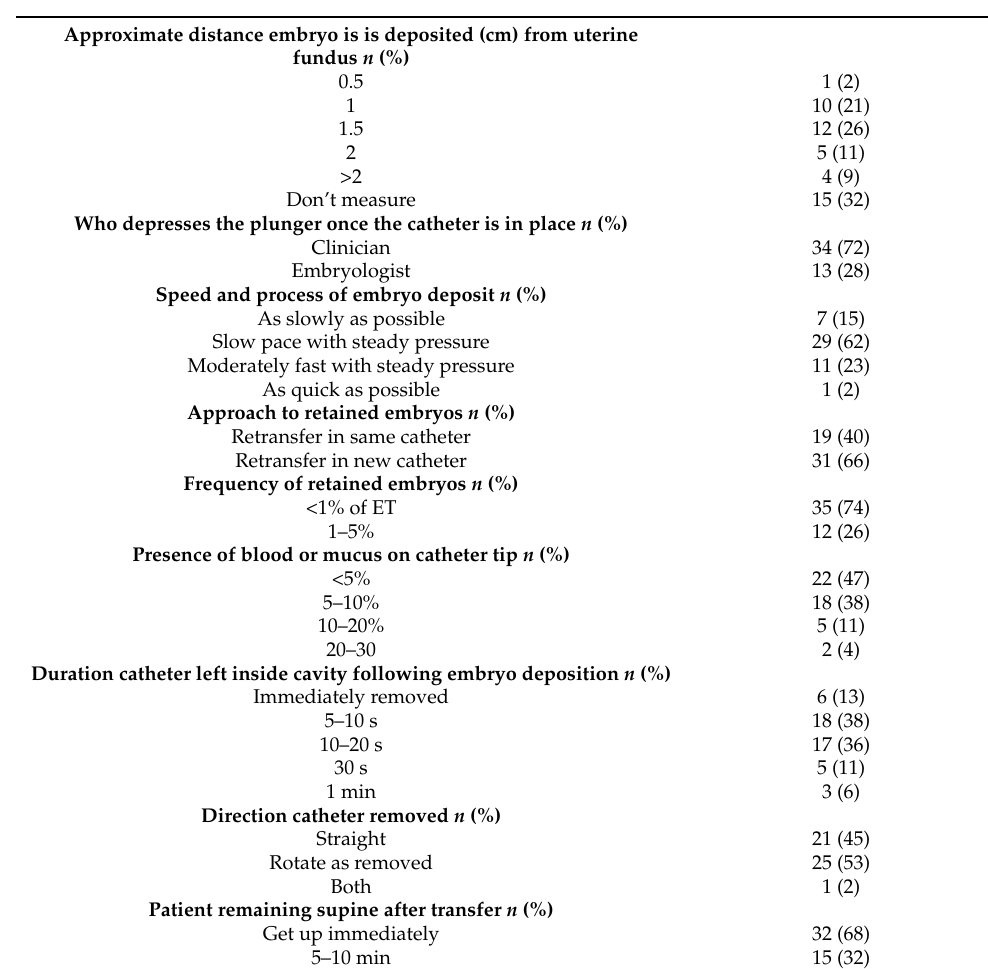
Table 5. Cont. Approximate distance embryo is is deposited (cm) from uterine